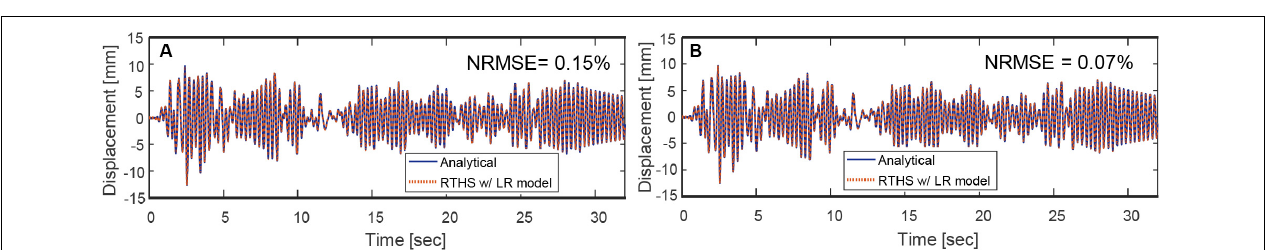
FIGURE 4 | Comparison of the brace displacement time histories from FE model and LR metamodel.